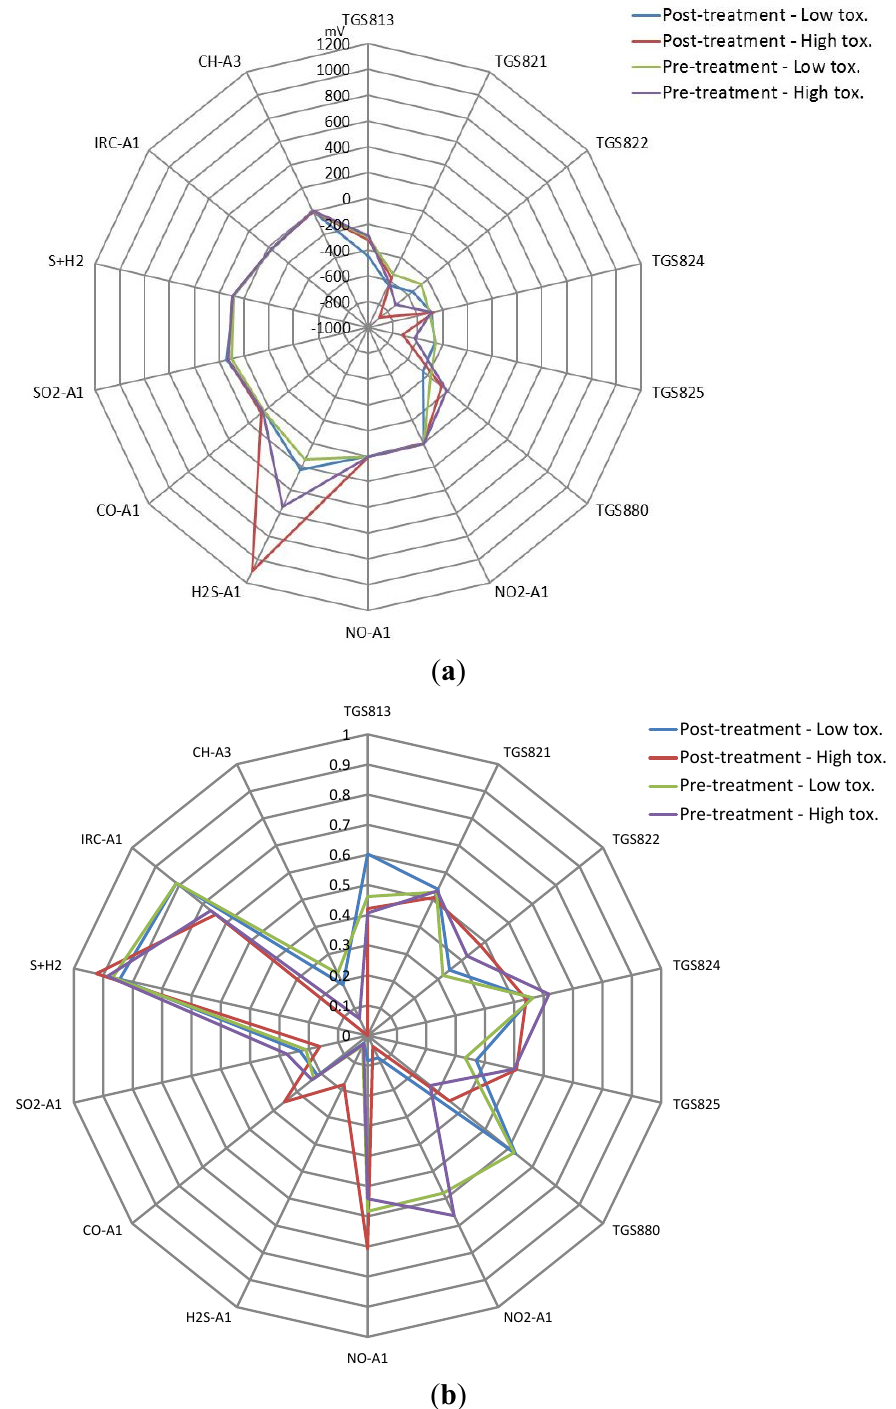
Figure 4. ( a ) Averaged e-nose sensor responses for different sample groups (axis is change in output voltage) and ( b ) Normalized